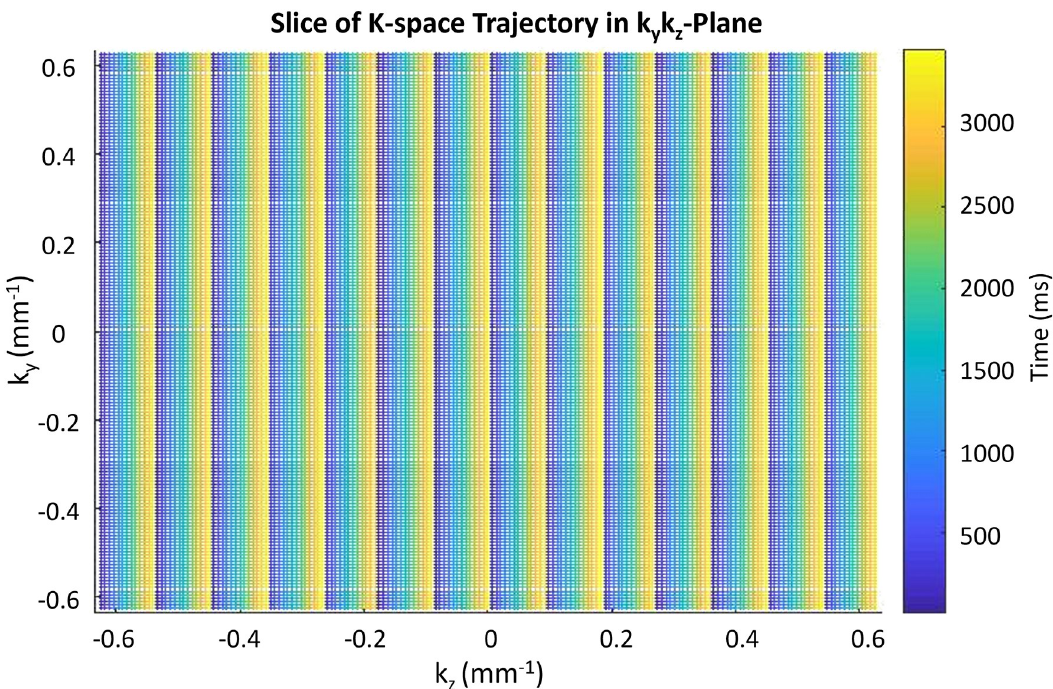
Fig 3. Cross-section of UnWRAP sequence in the k y k z plane. In this scan sequence, k -space is divided into 14 sections, which are each separated into 14 sheaves. Each section must have one sheaf scanned before any section can have another sheaves scanned. This scheme ensures a nearly uniform distribution of high and low spatial frequencies are present in each reconstructed image, while still satisfying the (spatial) Nyquist criterion when all scan data are combined.